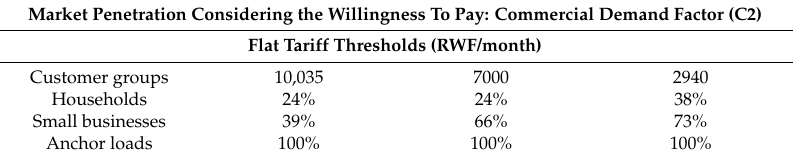
Table 4. Market penetration considering the willingness to pay (WTP).